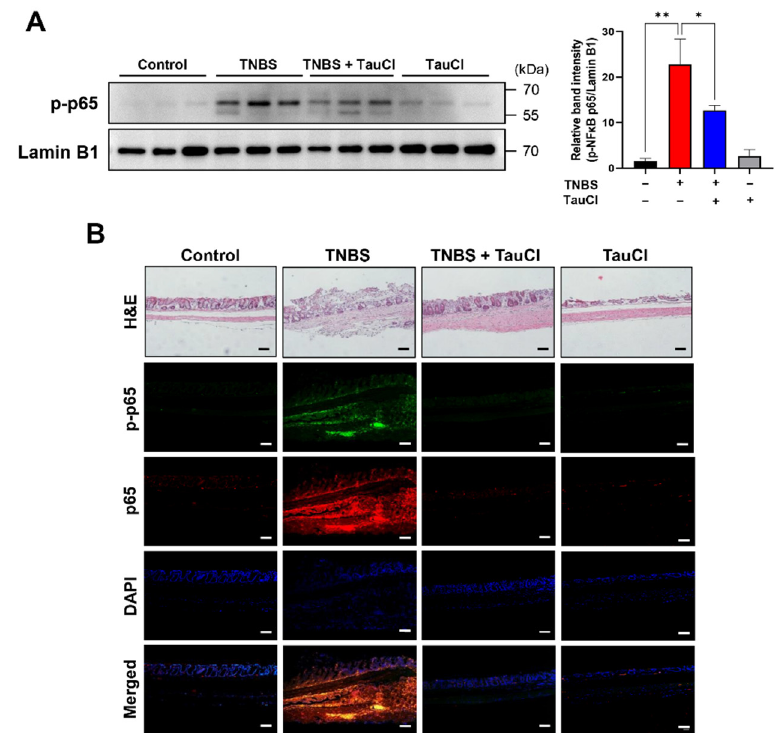
Figure 4. Inhibitory effects of TauCl on TNBS-induced p65 phosphorylation and nuclear localization of NF κ B. ( A ) Expression of the phosphorylated NF κ B p65 subunit was determined by Western blot analysis using nuclear extracts. ( B ) Accumulation of the phosphorylated as well as the total form of p65 was measured by immunofluorescence staining. The same tissue sections were stained with H&E. Scale bar, 200 µ m. Results are presented as means ± SD. * p < 0.05; ** p < 0.01.